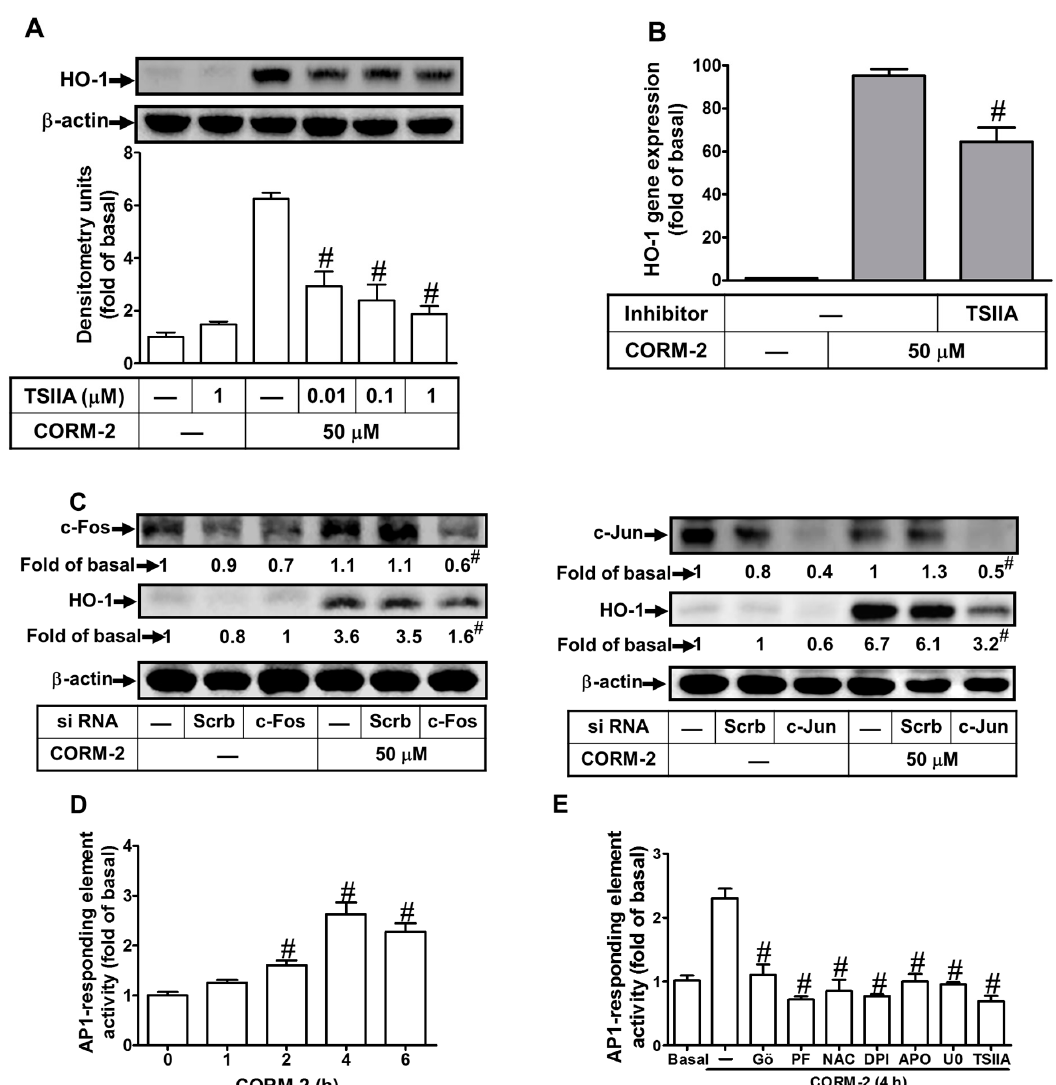
Figure 7. Involvement of c-Fos and c-Jun / activator protein 1 (AP-1) in CORM-2-mediated HO-1 expression. ( A ) Cells were pretreated with tanshinone IIA (TSIIA) for 1 h, and then incubated with CORM-2 for 24 h. The protein levels of HO-1 and β -actin (served as an internal control) were determined by Western blot. ( B ) Cells were pretreated with TSIIA (1 µ M) for 1 h, and then incubated with CORM-2 for 6 h. The mRNA expression of HO-1 was determined by real-time PCR. ( C ) Cells were transfected with either scrambled (Scrb), c-Fos, or c-Jun siRNA, and then incubated with CORM-2 for 24 h. The levels of c-Fos, c-Jun, HO-1, and β -actin (served as an internal control) protein were determined by Western blot. ( D ) Cells were transiently cotransfected with pAP1-Luc (activator protein-1 luciferase reporter plasmid) and pGal (plasmid contains the reporter gene β -galactosidase) for 24 h, and then incubated with CORM-2 for the indicated time intervals. ( E ) Cells were pretreated with Gö6983 (10 µ